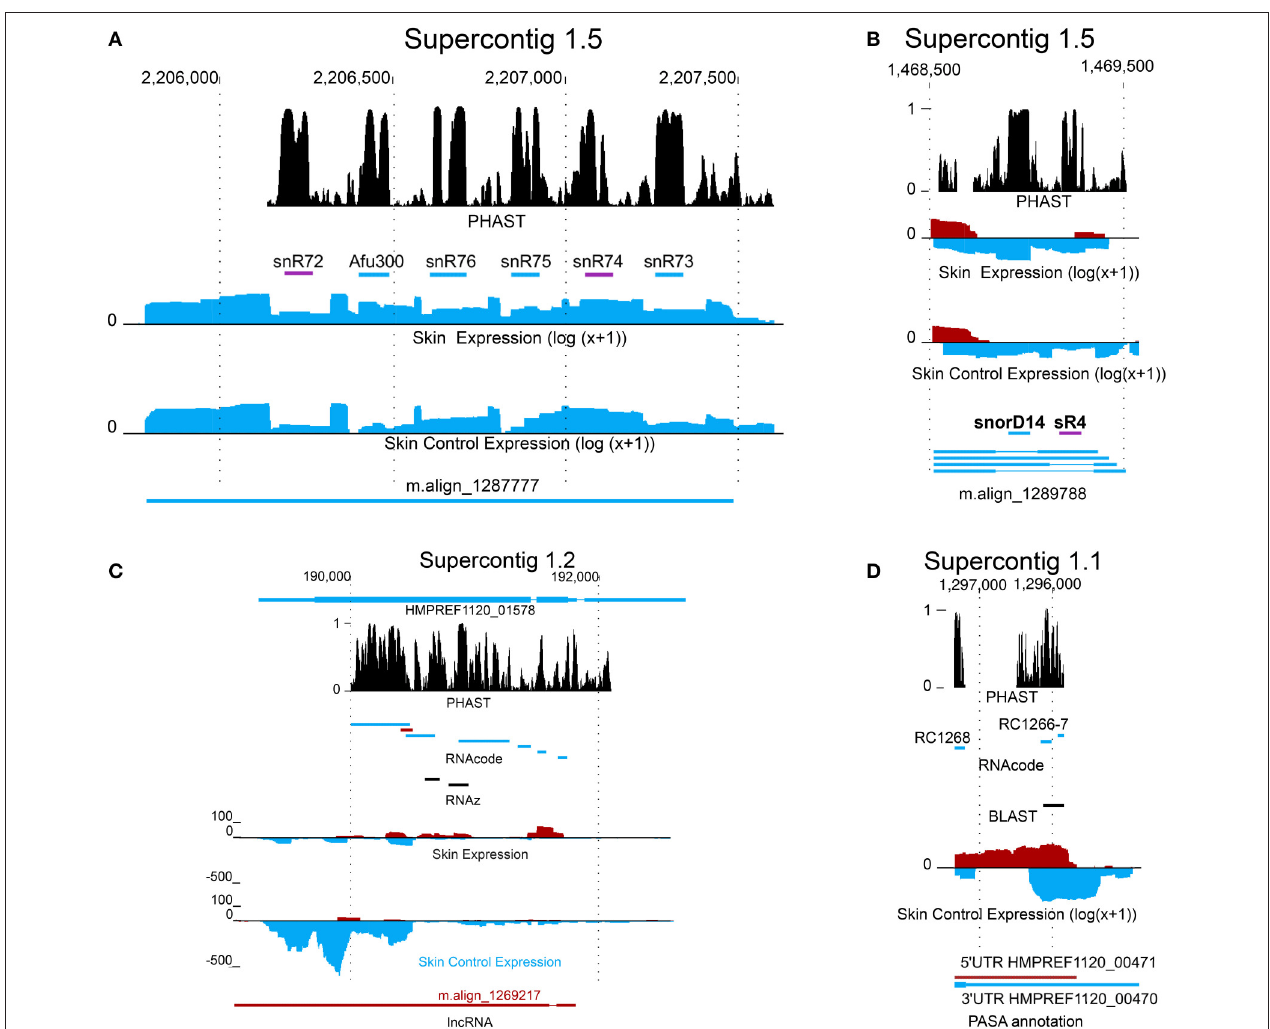
FIGURE 3 | New coding and non-coding genes in Exophiala dermatitidis . (A) m.align_1287777 is a spliced non-coding transcript containing intronic snoRNAs. snR72 and snR74, both shown as were annotated in this study. (B) The transcripts encoded in region Supercontig_1.5 1468500-1469500 contains two intronic snoRNAs, snorD14 and sR4. snorD14 is upregulated when Exophiala dermatitidis grows on the ex-vivo skin samples. (C) lncRNA m.align_1269217 and HMPREF1120_01578 are antisense and exhibit opposite regulation pattern. They are located in a conserved region where the secondary structure and the coding potentials are constrained. (D) An homolog of Candida albicans metallothionein, shown as black bar, was found in a conserved region overlapping with the 3UTR of HMPREF1120_00470. The coding potential of the region encoding the metallothionein is further sustained by the RNAcode predictions RC1266 and